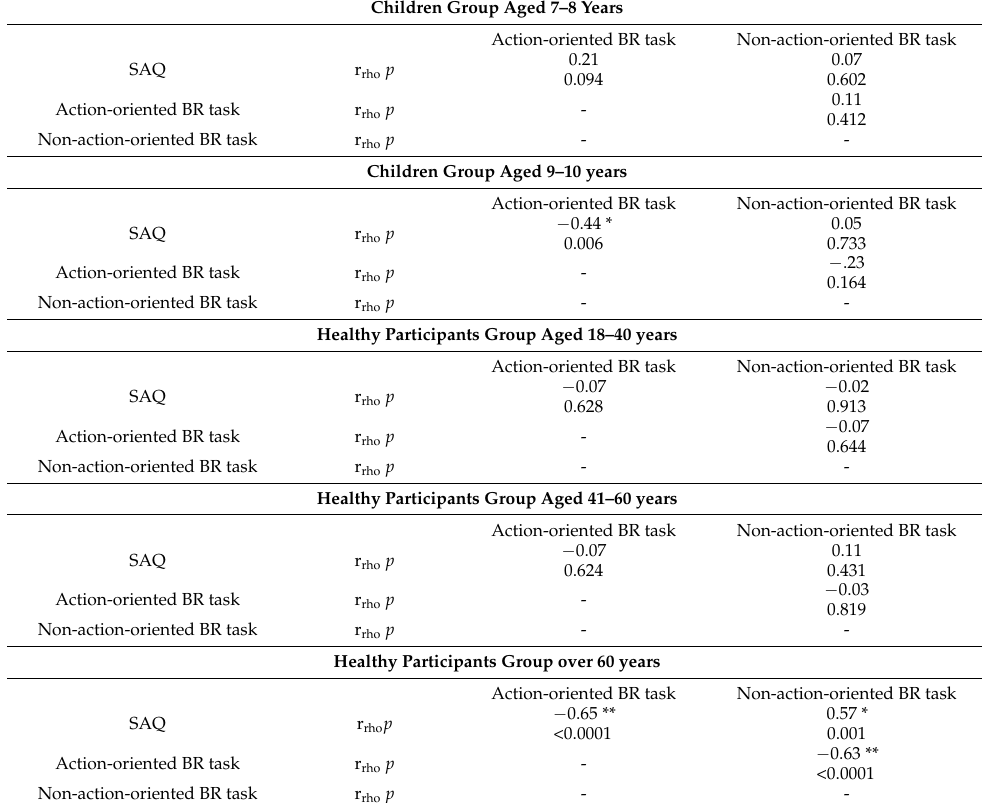
Table 2. Correlations between SAQ total score and the unstandardized residuals of the BR tasks on the respective control